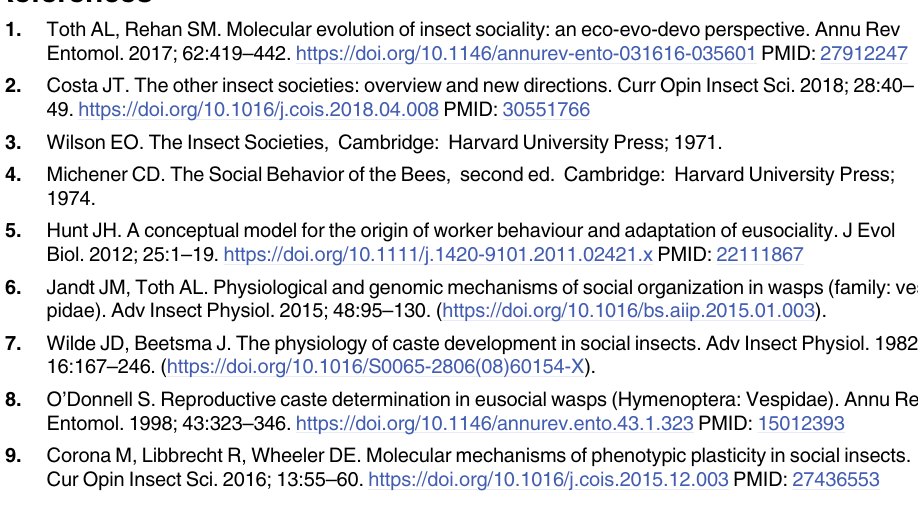
S1 Table. Data of head width and lipid stores in four Polistes species. S2 Table. Data of monoamine levels in the brain of Polistes snelleni . S3 Table. Data of monoamine levels in the brain of Polistes chinensis . S4 Table. Data of monoamine levels in the brain of Polistes rothneyi . S5 Table. Data of monoamine levels in the brain of Polistes jokahamae . S6 Table. Tests of normality and equal variance in each